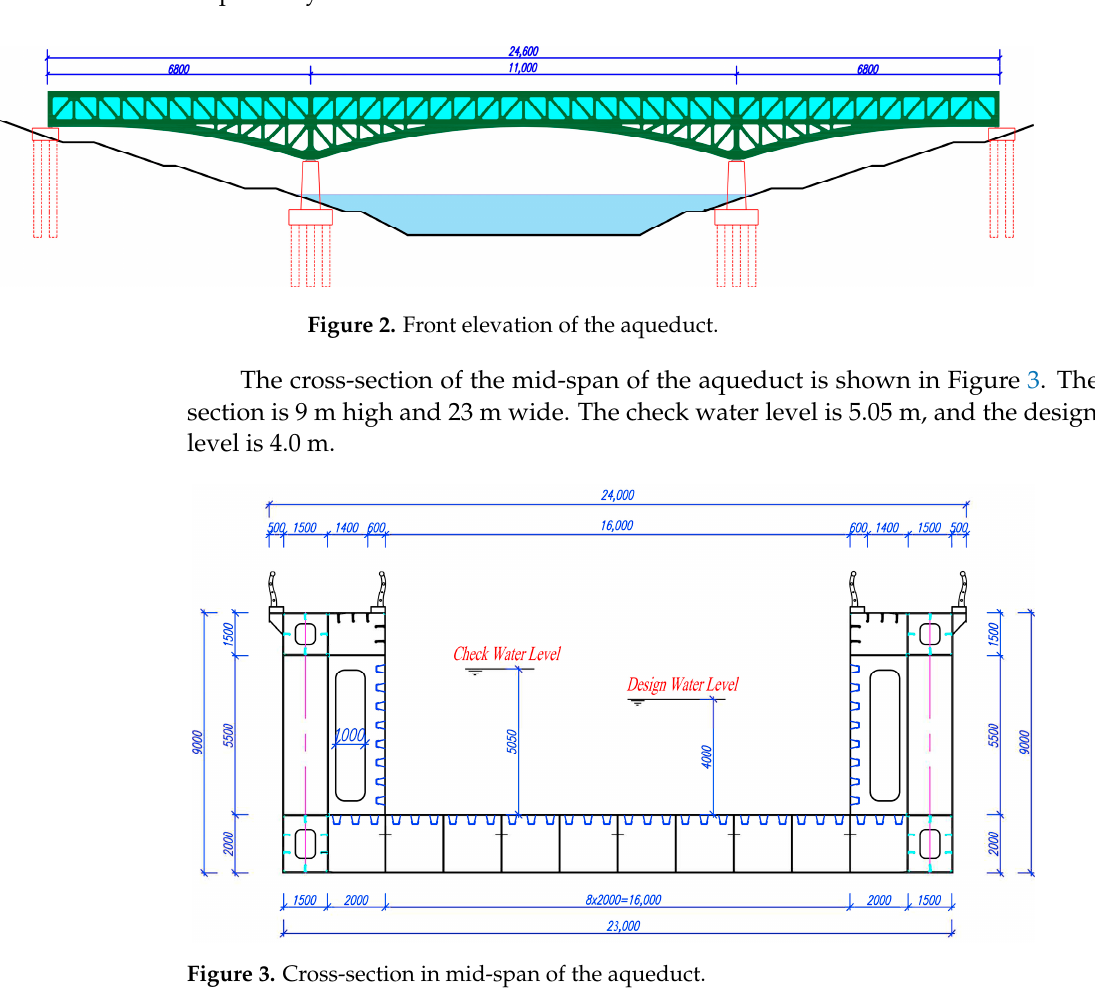
Figure 1. Location of the steel truss aqueduct.